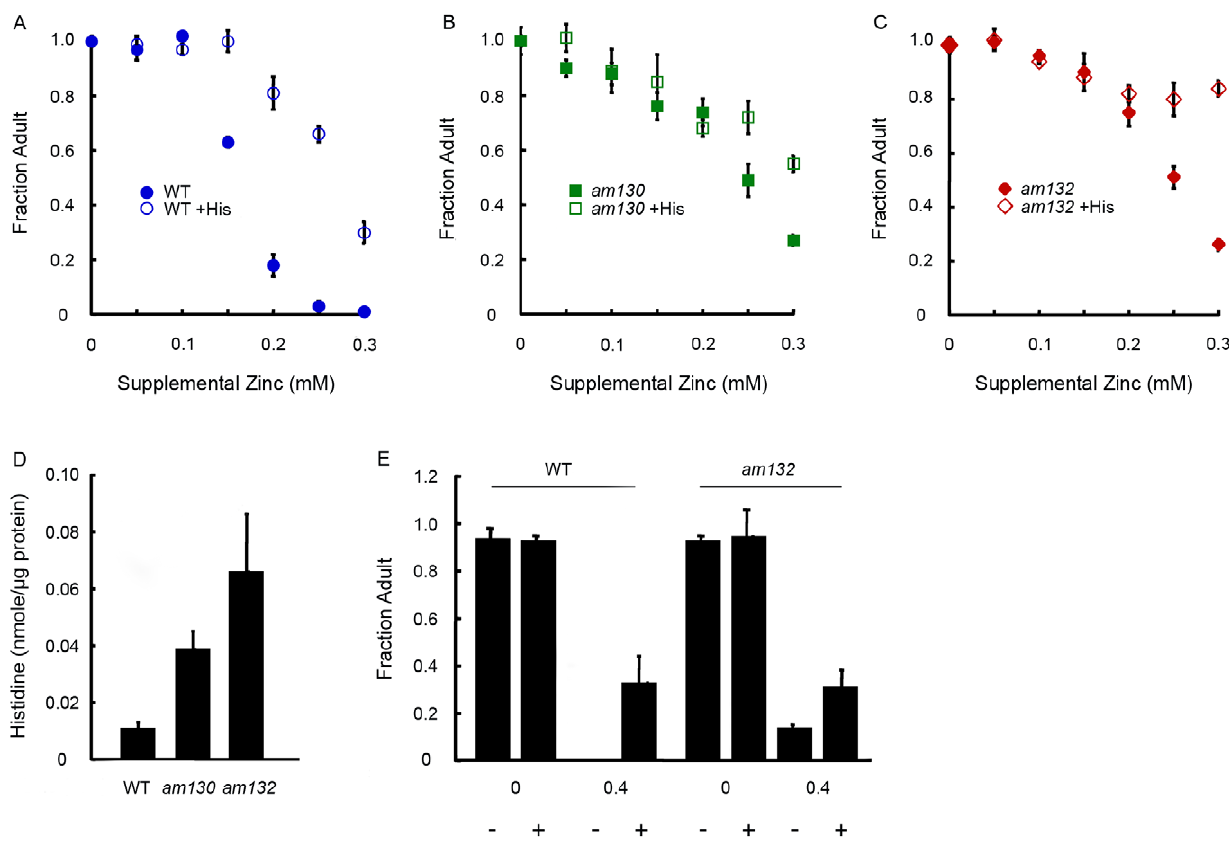
Figure 6. Histidine is elevated in haly-1 mutant animals, and dietary histidine promotes zinc tolerance. Wild-type (A), haly-1(am130) (B) and haly-1(am132) (C) hermaphrodites were synchronized at the L1 stage and cultured on NAMM supplemented with zinc (mM). Closed symbols indicate culture without histidine, and open symbols indicate culture with 0.1 mM histidine. The fraction of worms that grew to adulthood over seven days was monitored; the data were normalized by setting the value at 0 mM supplemental zinc equal to 1.0. Each point indicates mean value 6 SE (n=4 replicates with 50 worms per replicate). The fraction adult for WT + His was significantly higher than WT at 0.15 mM and higher concentrations of supplemental zinc (p , 0.0005). The fraction adult for haly-1(am130) + His was significantly higher than haly-1(am130) at 0.25 mM and higher concentrations of supplemental zinc (p , 0.03). The fraction adult for haly-1(am132) + His was significantly higher than haly-1(am132) at 0.25 mM and higher concentrations of supplemental zinc (p , 0.005). (D) Populations of animals consisting of a mixture of developmental stages were cultured in CeMM with either 0, 0.075 or 1.5 mM zinc. Total histidine content was determined by amino acid analyzer and calculated in nmoles L-histidine per m g protein. The histidine values for wild-type and mutant strains were not significantly affected by the level of dietary zinc (data not shown), and bars indicate mean values 6 SE of six independent experiments comprised of two samples at each concentration of dietary zinc. Values for wild type were significantly different than values for haly-1(am130) (p=0.0009) and haly-1(am132) (p=0.019), whereas values for the two mutant strains were not significantly different (p=0.22). (E) Wild-type and haly-1(am132) hermaphrodites were synchronized at the L1 stage, cultured on NAMM supplemented with 1 mM L-histidine ( + ) or 0 mM L-histidine ( 2 ) and no supplemental zinc for 24 hours, washed extensively, and then cultured on NAMM supplemented with 0 mM or 0.4 mM zinc and 0 mM L-histidine for six days. The fraction of worms that grew to adulthood over seven days was monitored. Bars indicate mean value 6 SE (n=4 replicates with 50 worms per replicate). At 0.4 mM supplemental zinc, values for wild-type worms pre-treated with L-histidine were significantly higher than values for worms that were not pre-treated (p=0.022). Values for haly-1(am132) animals pre-treated with L-histidine were higher than values for animals that were not pre-treated (p=0.06).